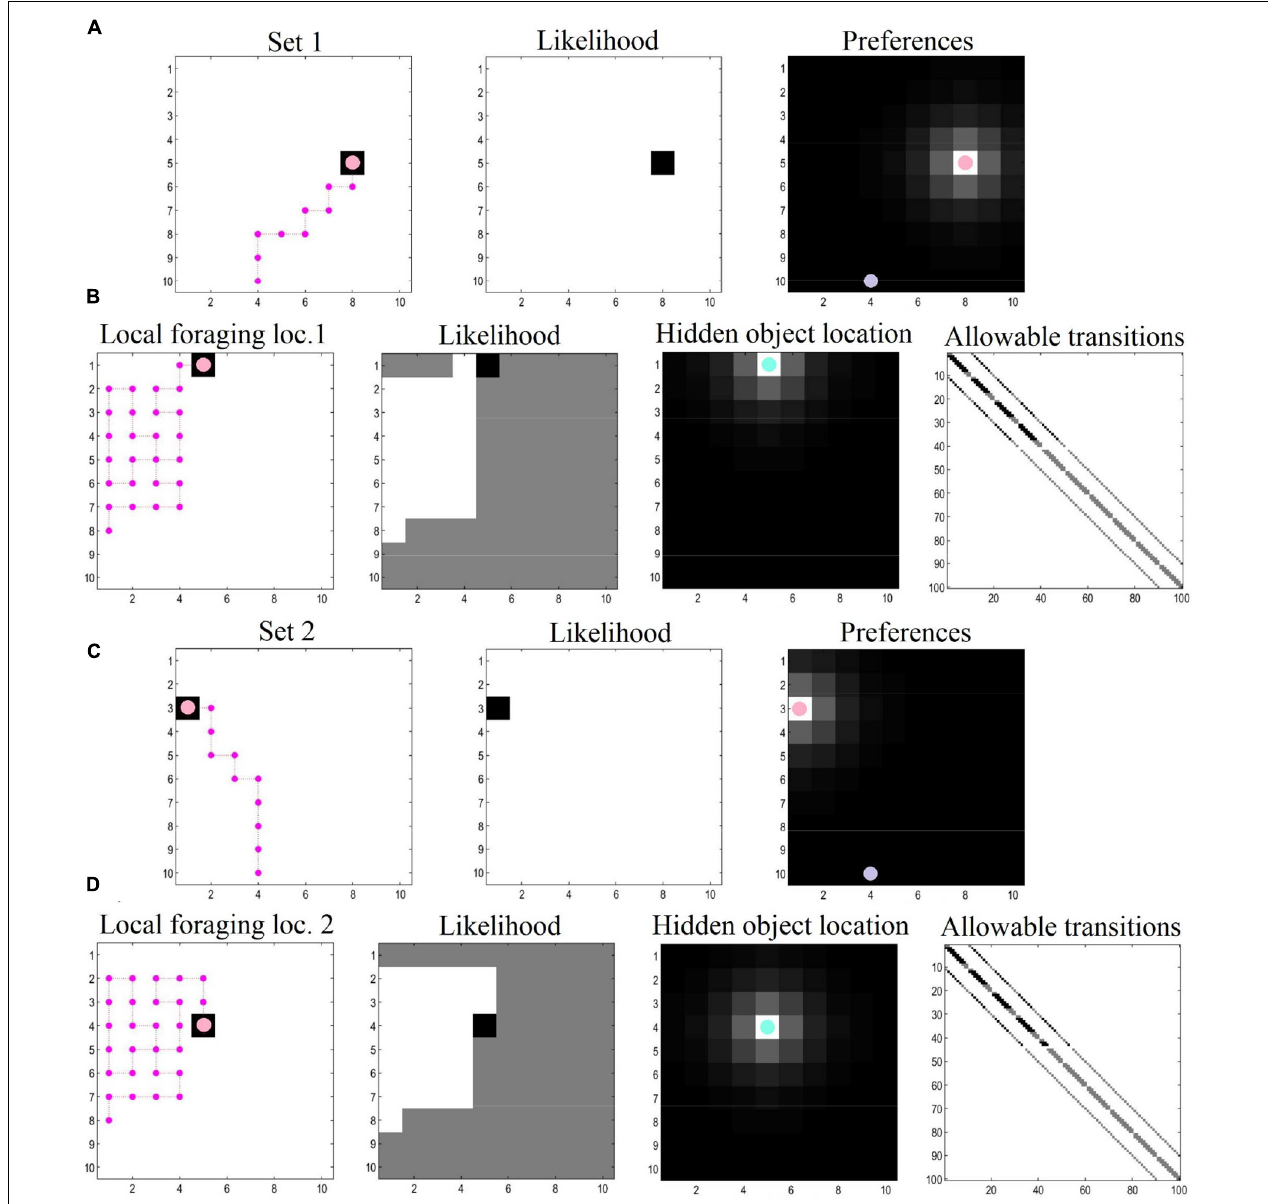
FIGURE 3 | Navigation and local foraging behavioral results. (A) The agent plans and executes its (shortest available) trajectory toward the first target location, driven by prior preferences. The purple dot indicates the starting location. The agent has learned the likelihood mappings, which can be interpreted as having—and making use of—a map to reach the target location. (B) When the target location is reached, the agent explores the local area to find a hidden object, as it learns and discovers its environment. Here, the agent starts with a uniform distribution about the likelihood mappings, and has additional uncertainty pertaining to the transition matrix (i.e., uncertainty about where the agent finds itself given where it was previously and the action it has taken). This process involves a dual pursuit: discovering the environment and fulfilling a desire to find the hidden object. (C,D) After finding the hidden object, the agent receives a new target location and the process repeats (possibly ad